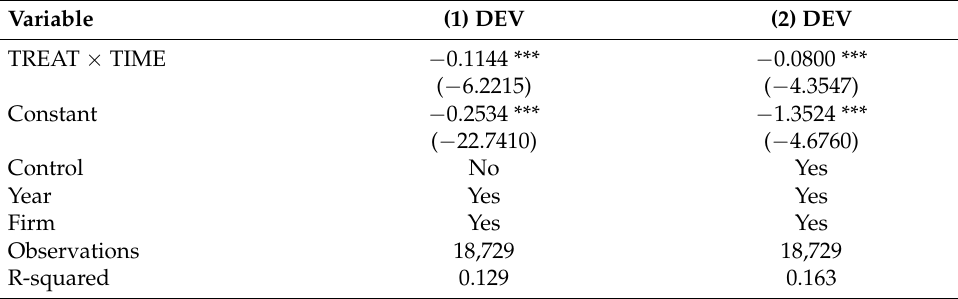
Table 12. Removal of other policy